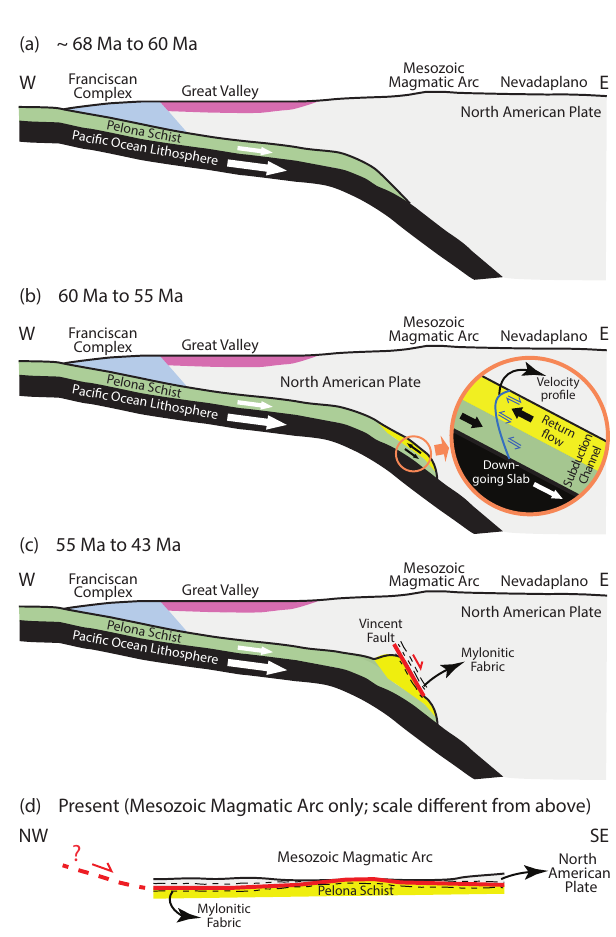
Figure 11. Tectonic model of the Pelona Schist. (a) The Pelona Schist was subducted no earlier than 68Ma and reached the peak condition by 60Ma. (b) The Pelona Schist exhumed by return flow. Close-up view shows the velocity profile of the material in the sub- duction channel. (c) The Vincent Fault exhumed the Pelona Schist to a shallower structural level. (d) Present-day setting of the Vin- cent Fault and the Pelona Schist after rotation and tilting. The scale in panel (d) is larger than those in panels (a–c)